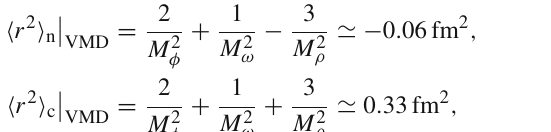
Fig. 6 Spacelike charged-kaon form factor (squared) data compared to the fits for all neutral or charged data sets